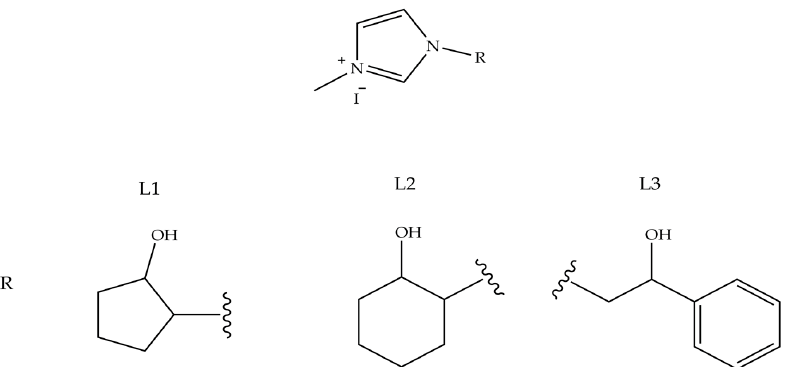
Figure 7. NH-Carbene proligands L1, L2 and L3, employed in AuL n ( n = 1–3) complexes. The antitumor activity of these complexes was evaluated on two breast cancer cell lines, MCF-7 and MDA-MB-231. The results obtained highlighted an interesting antitumor activity of the compounds shown in Figure 8, in particular on the highly aggressive and metastatic MDA-MB-231 cell line. In vitro studies have shown that these compounds are able to interfere with tubulin polymerization by inhibiting the activity of hTopo I and II, already at the minimum concentration of 1 M. Therefore, these results have shown that these compounds may be useful for further future investigations enabling the development of new multitarget agents in the treatment of breast cancer.